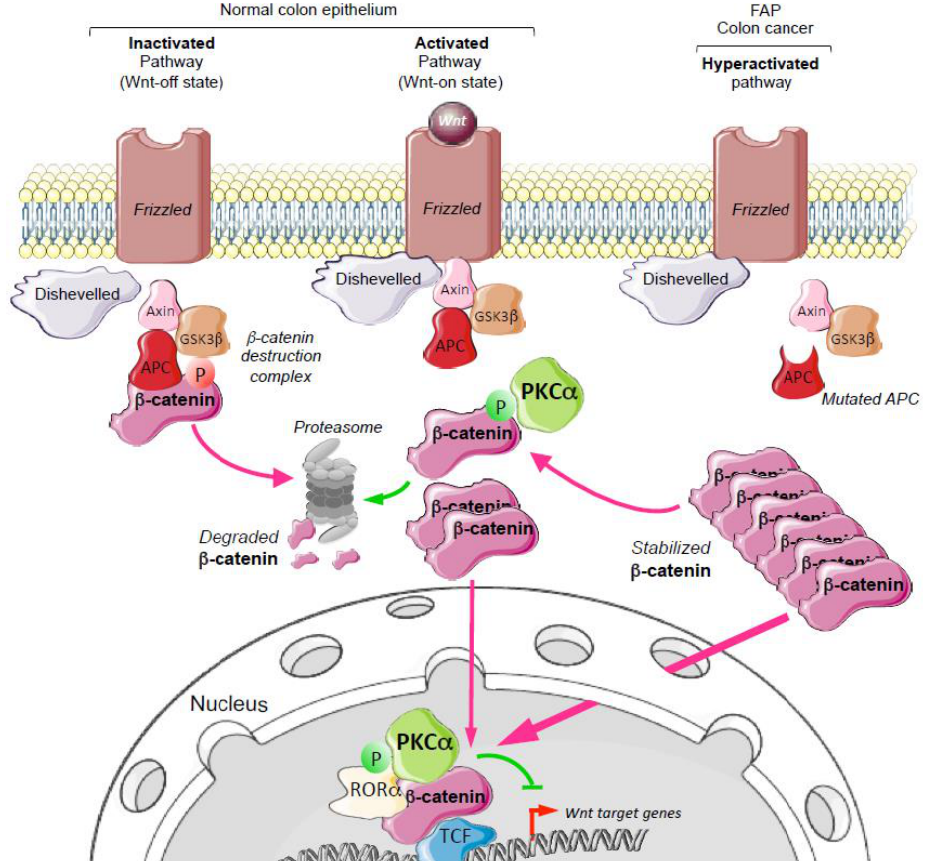
Figure 2. Schematic view of PKC α inhibitory activity on the Wnt / β -catenin signaling pathway in the normal colon epithelium and in colon cancer. In normal tissue, when the pathway is inactive (Wnt-o ff state, absence of Wnt ligand), β -catenin is phosphorylated by the kinase GSK3- β of the destruction complex. This is the signal for β -catenin ubiquitination and subsequent degradation by the proteasome. When the pathway is active (Wnt-on state, presence of Wnt ligand), the β -catenin destruction complex is recruited and inactivated at the plasma membrane through a dishevelled-dependent process. In this situation, β -catenin is neither phosphorylated nor ubiquitinated, and thus is not degraded by the proteasome; consequently, it accumulates in the cell including in the nucleus, where it activates T-Cell transcription Factor (TCF) to induce the expression of Wnt target genes. In colon cancer, the β -catenin destruction complex is constitutively inactive due to APC mutations. In this situation, β -catenin constitutively accumulates and co-transcriptionally activates the expression of Wnt target genes. PKC α , which acts downstream of APC, can inhibit the activity of the pathway in both normal and tumor cells: PKC α -induced phosphorylation of β -catenin targets β -catenin for degradation, while PKC α -induced phosphorylation of the orphan receptor ROR α inactivates β -catenin co-transcriptional activity. FAP, Familial Adenomatous Polyposis.